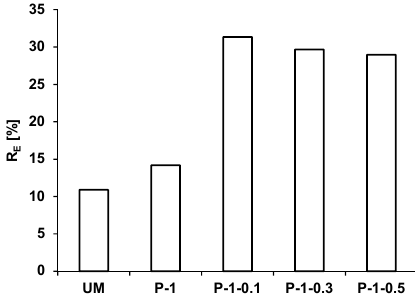
Figure 4. Photocatalytic efficiency during RO removal from gypsum samples under visible irradiation.